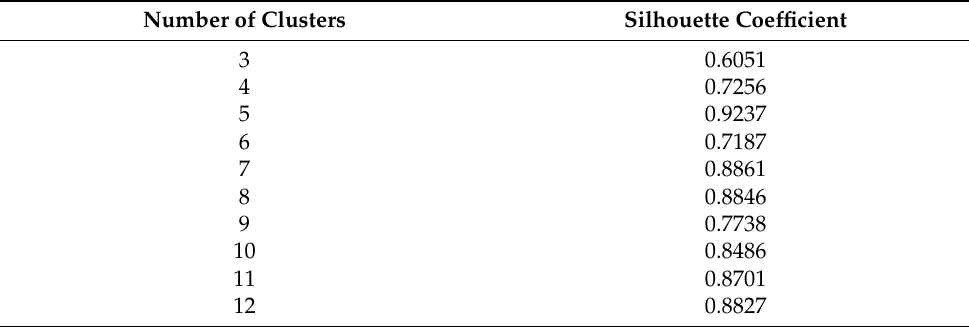
Table 6. The results obtained for the silhouette coefficient.